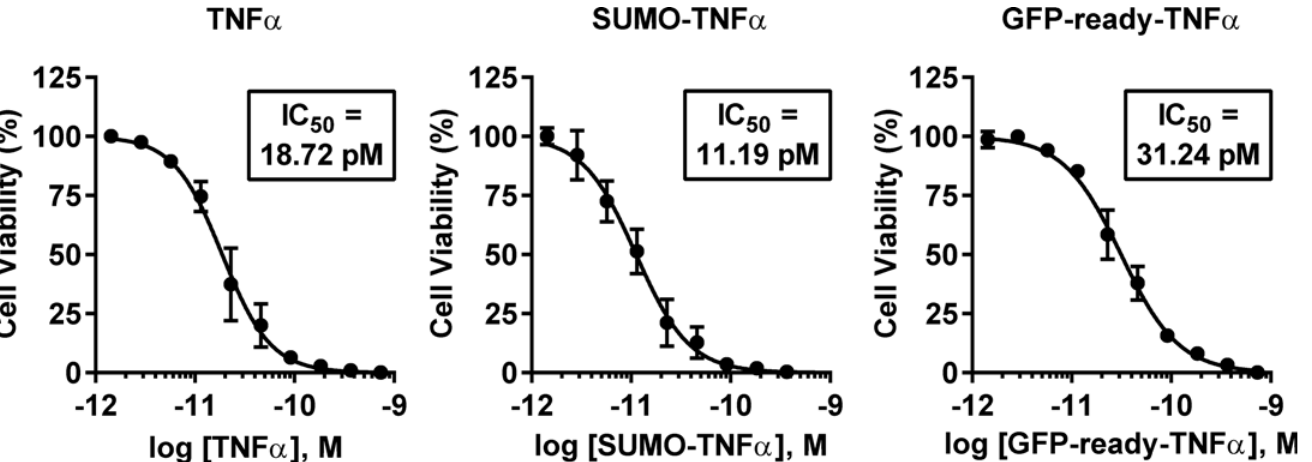
Fig 7. Cell growth inhibition of TNF α fusions. TNF α activity was assessed by measuring cell viability (n = 3) using the XTT assay on L929 sensitized cells with actinomycin-D and concentration range of TNF α fusions (untagged soluble TNF α , SUMO-TNF α or GFP-ready-TNF α from left to right). Individual IC 50 values were determined from curve